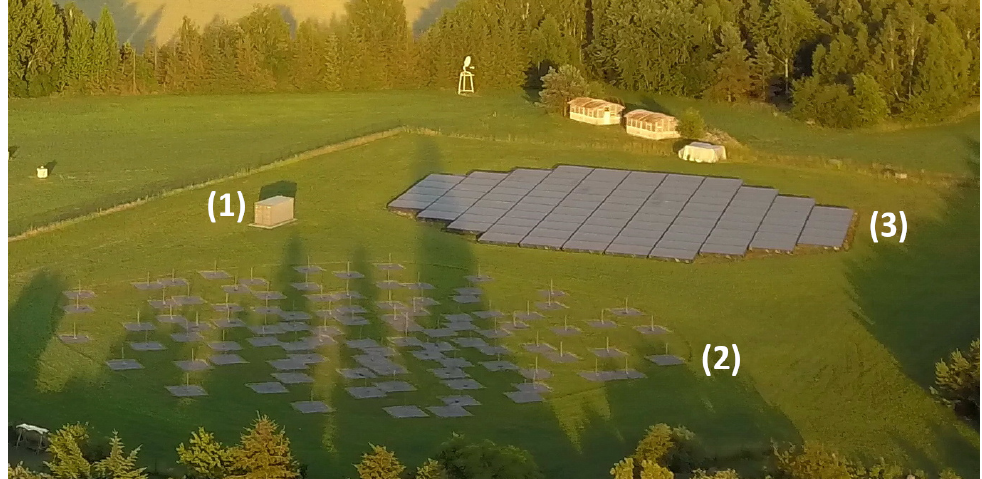
Figure 2. LOFAR PL610 station in Borowiec, Poland, owned by SRC PAS. From left to right: (1) container with electronic equipment, (2) LBA antennas, (3) HBA